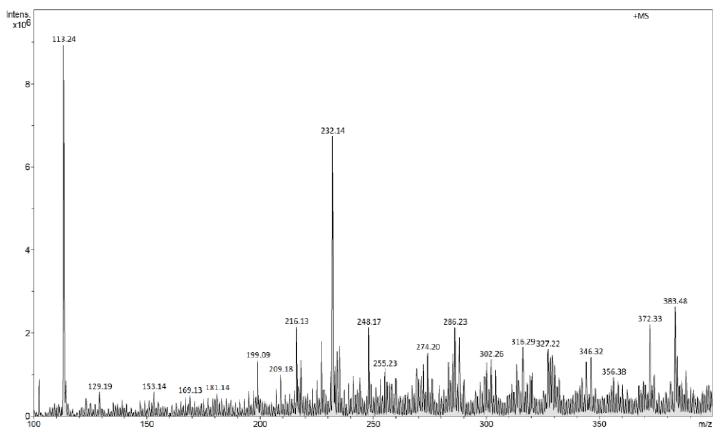
Figure 6. FAPA-MS spectrum of MIP in the range of negative ions.